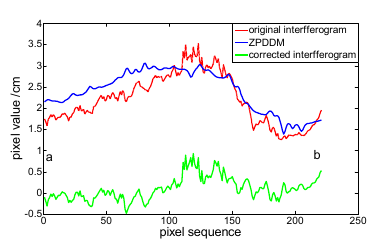
Figure10. Comparison of original/corrected interferogram and ZPDDM at cross-section （ a-b